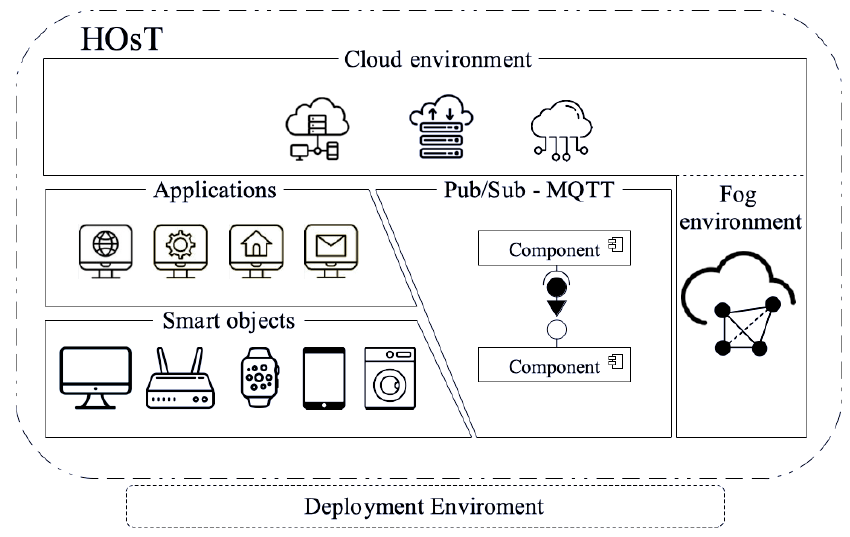
Figure 1. HOsT operating